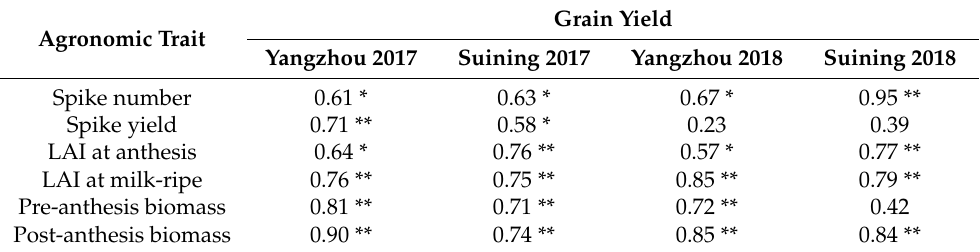
Table 5. Correlations between grain yield and yield components, leaf area index (LAI) and biomass, of different cultivars in southern (Yangzhou) and northern (Suining) areas of the Yangtze River